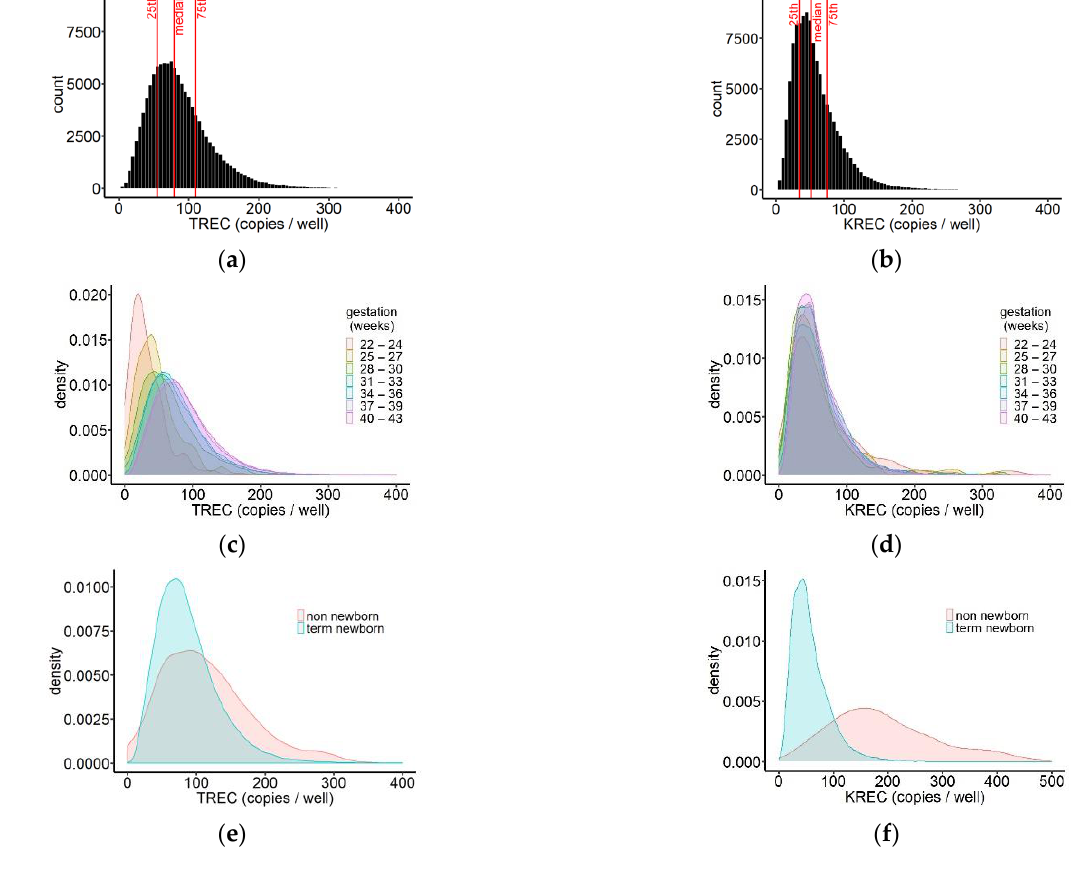
Figure 3. Distribution of TREC ( a ) and KREC ( b ) values in the screened population. Median (IQR) TREC = 79 (55, 110); overall, 55 samples had TREC values above 400 copies/well (data not shown); median (IQR) KREC = 51 (34, 75), and 42 samples had KREC values above 400 copies/well (data not shown); n = 115,757. Distribution of TREC ( c ) and KREC ( d ) values in new- borns for different gestational ages represented by density plots. n = 115,189; samples above 400 copies/well are not shown; ( e ) density plot of the distribution of TREC values in screened non-newborns ( n = 563), compared to term newborns ( n = 108,508), showing a comparatively larger percentage of non-newborn children with very low or very high TREC concen- trations. The median TREC concentration was 103 copies/well (IQR 64, 150) in non-newborns and 80 copies/well (IQR 56, 111) in term newborns; ( f ) density plot of the distribution of KREC values in screened non-newborns and term newborns showing a right shift of the KREC results for non-newborns in comparison to term newborns. The median KREC concen- tration was 180 copies/well (IQR 135, 258) in non-newborns and 51 copies/well (IQR 34, 74) in term newborns.